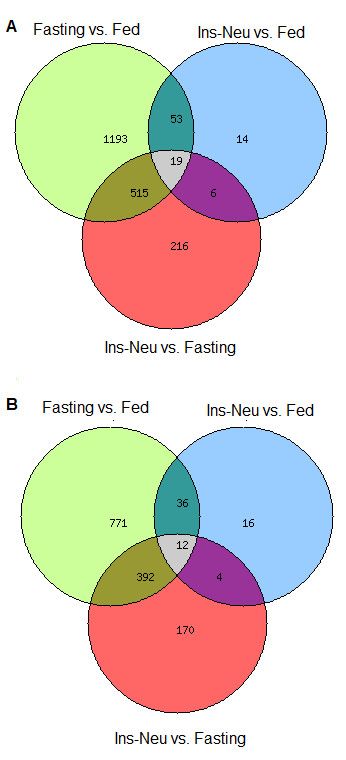
Venn diagram of overlapping and unique effects of fasting and insulin neutralization on gene expression. (A) A total of 2016 unique genes were differentially expressed (FDR adjusted p-value <0.05) between one or more pairwise treatment comparisons; (B) A total of 1401 genes with absolute fold change ≥1.5 among the differentially expressed genes.